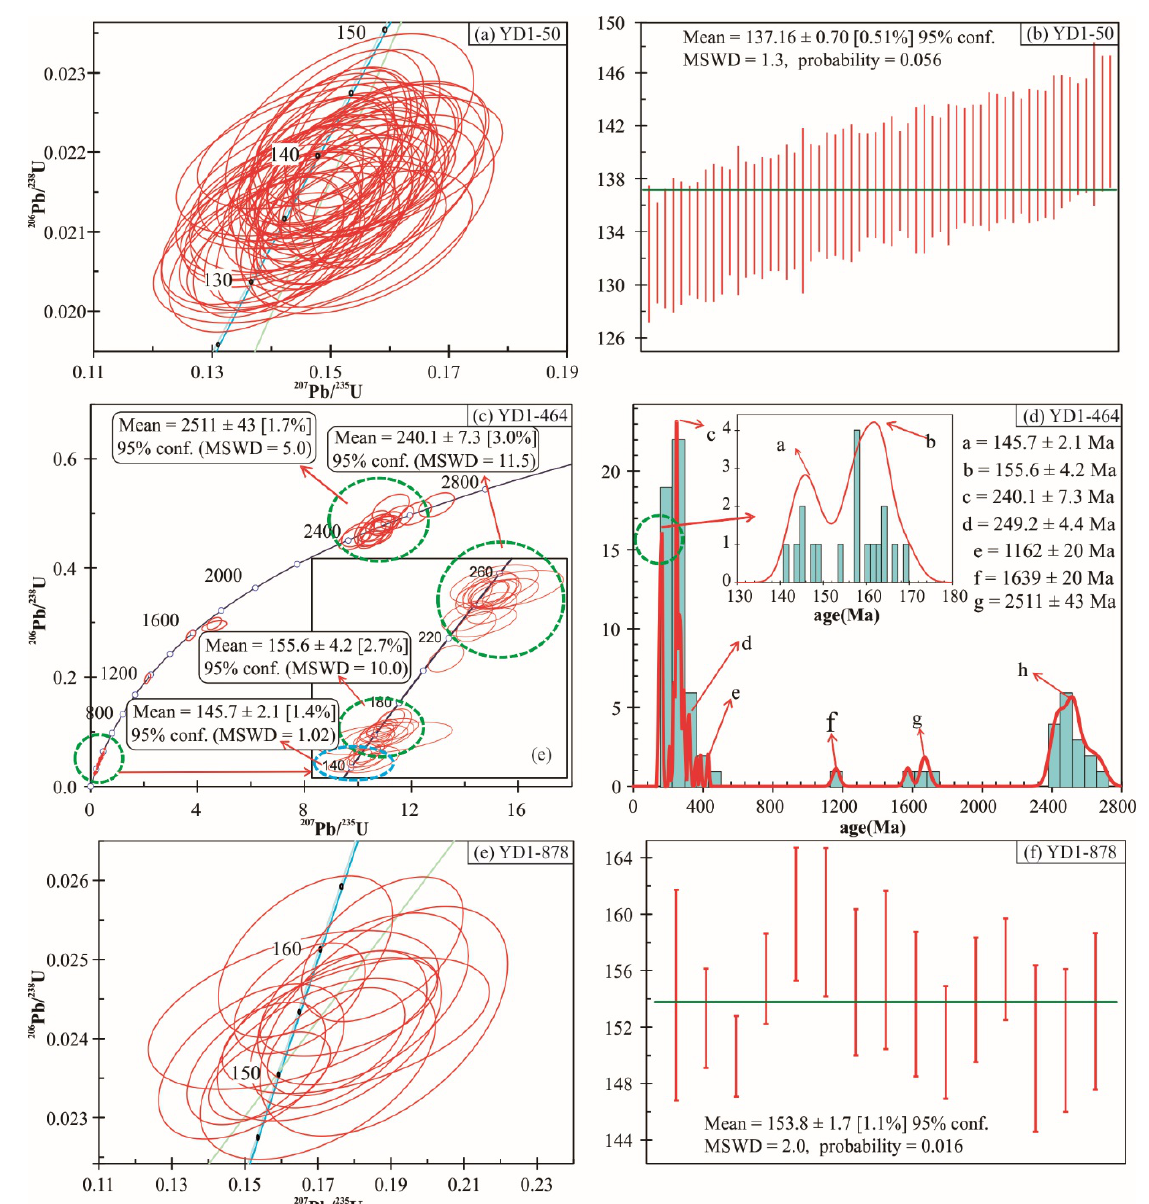
Figure 5. U ‐ Pb Concordia diagram, frequency histogram, and weighted isochron diagram of zircon ages for samples from the Tuchengzi Formation. ( a ) U ‐ Pb age Concordia diagram and ( b ) U ‐ Pb weighted isochron diagram of YD1 ‐ 50 magma zircon; ( c ) U ‐ Pb age Concordia diagram and ( d ) U ‐ Pb frequency histogram of YD1 ‐ 464 detrital zircon; ( e ) U ‐ Pb age Concordia diagram and (f) U ‐ Pb weighted isochron of YD1 ‐ 878 magma zircon.